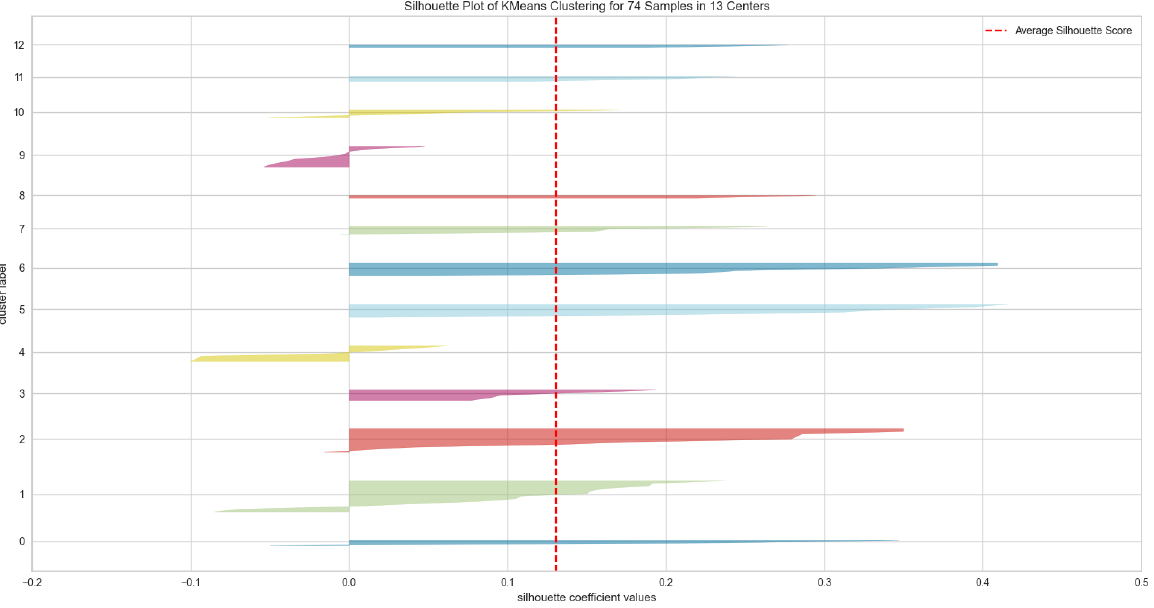
Figure 7. The Silhouette score when the number of cluster K =